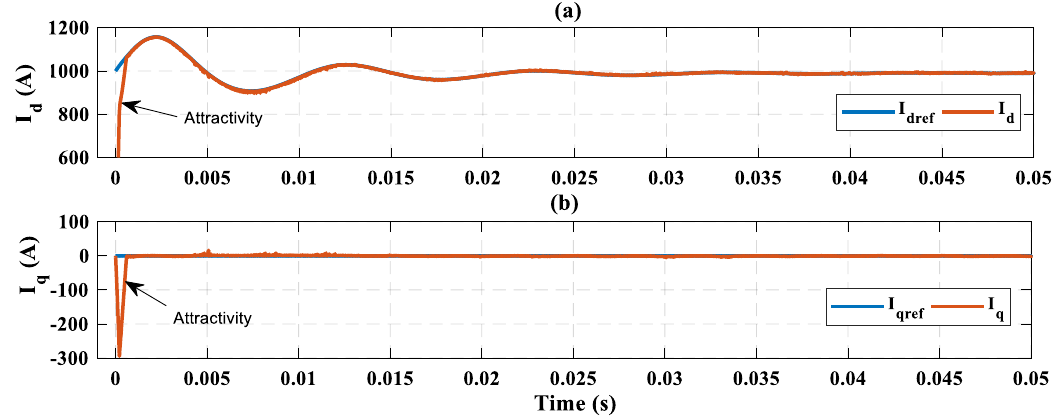
Figure 8 . Output current; ( a ) d-axis current; ( b ) q-axis current . Figure 8. Output current; ( a ) d-axis current; ( b ) q-axis